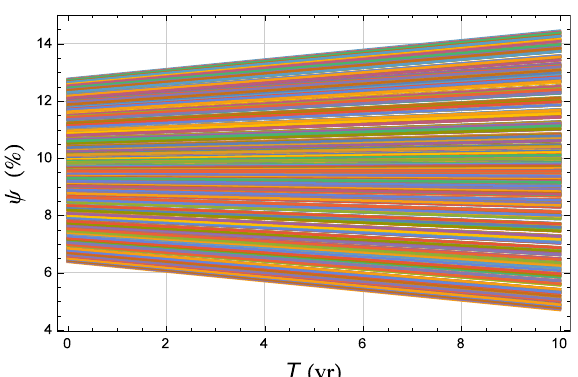
Figure A3. Scatter over 10 yr of the per cent error ψ calculated by means of Equations (11) and (12) in Equation (6) by allowing Ω L , Ω CL to vary independently of each other within a range 360 deg wide. 0 0 The values δ C 2,0 = 2.5 × 10 − 10 (see Table A2), and ∆ a CL = 20 km, ∆ I CL = 0.5 deg were adopted for